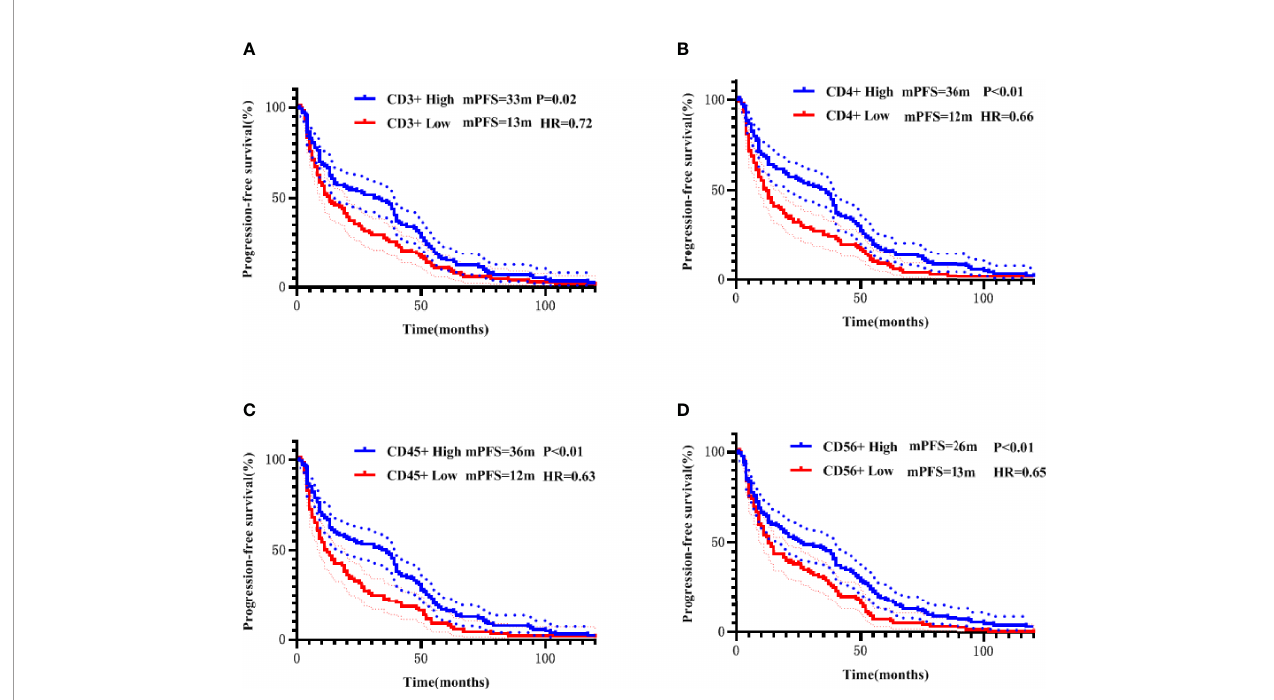
subsets did not show prognostic signi fi cance in the early disease group. In the metastatic disease group, Kaplan-Meier analysis